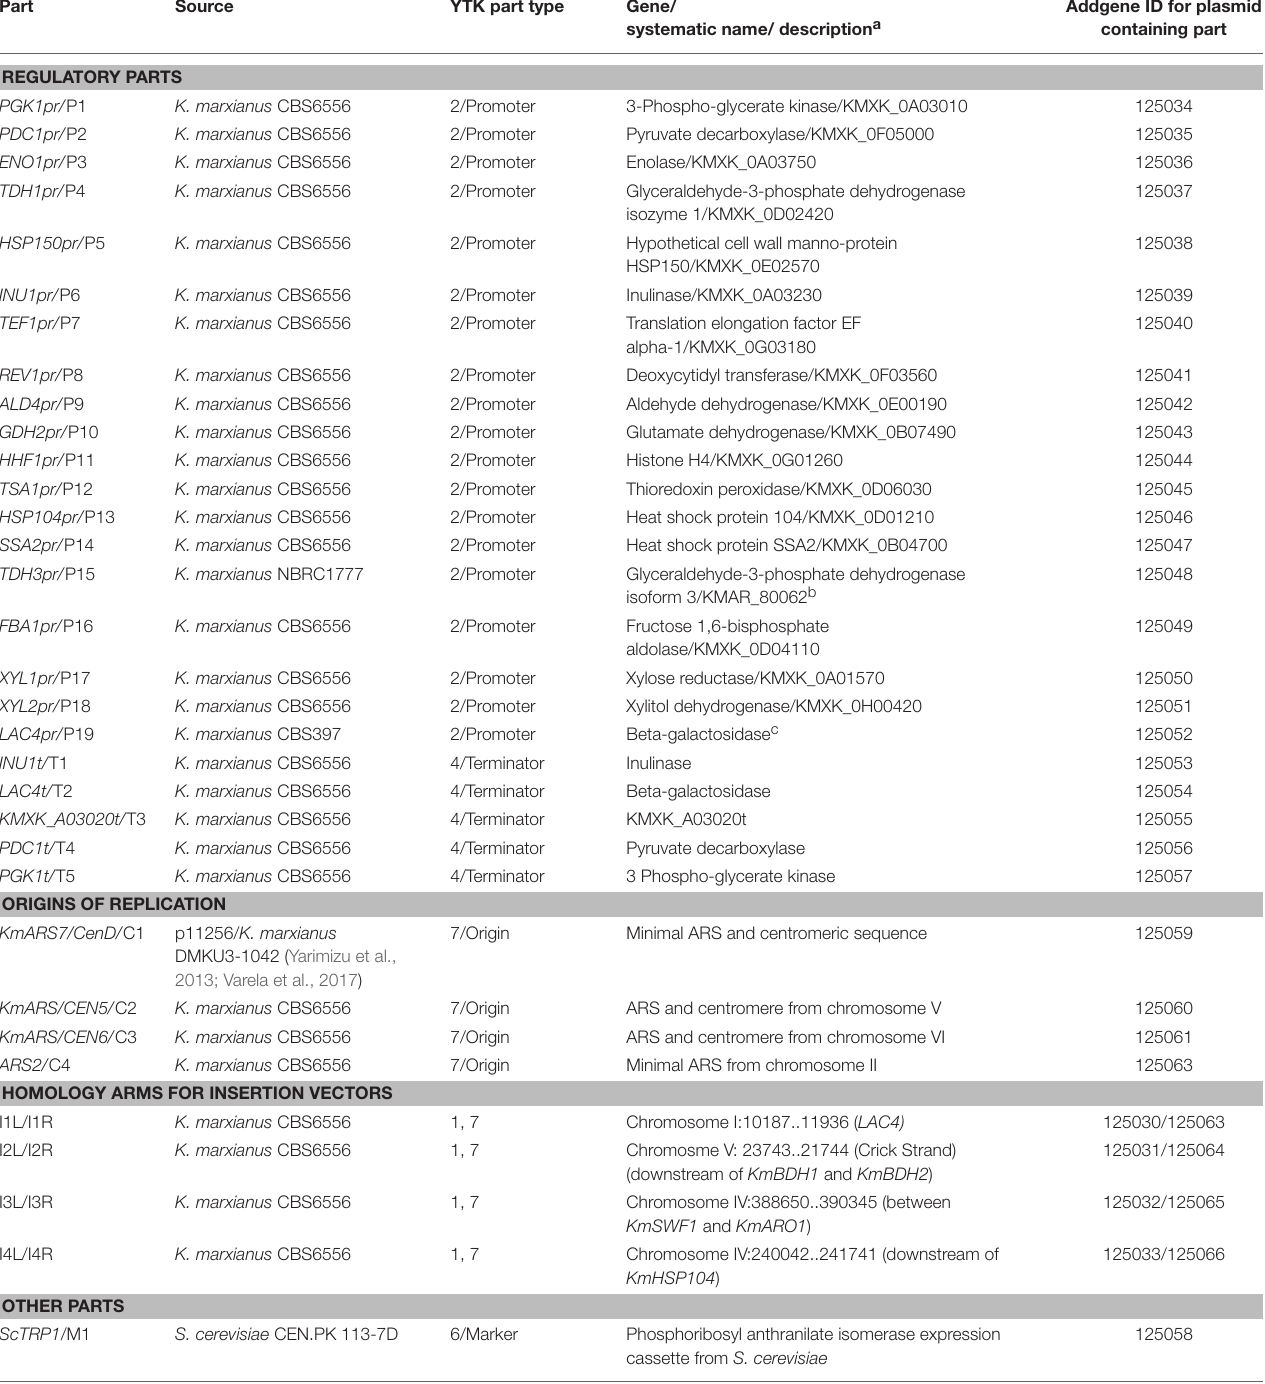
TABLE 2 | List of parts provided in the